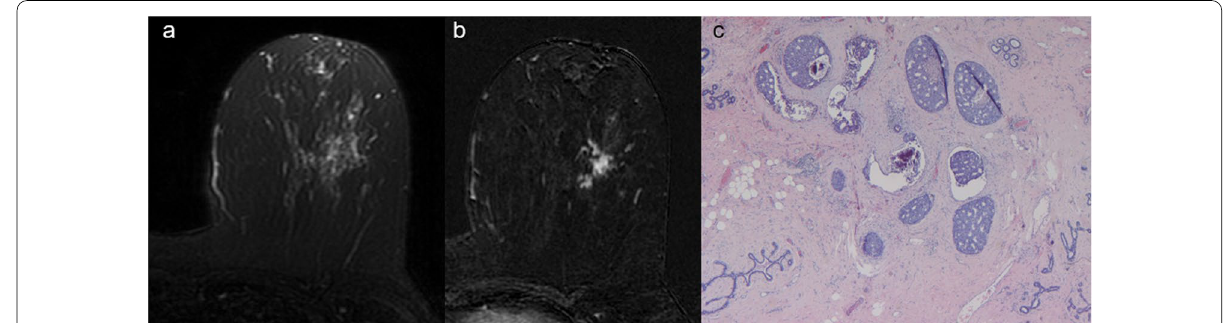
Fig. 1 A 59-year-old woman with ductal carcinoma in situ of the left breast. a Axial fat-suppressed T2-weighted image shows a 21-mm isointense lesion in the lower outer quadrant of the left breast. b Axial post-contrast T1-weighted subtracted images show a corresponding regional, clumped non-mass enhancement. c Histological examination confirms the suspicion of in situ carcinoma highlighting several intraductal